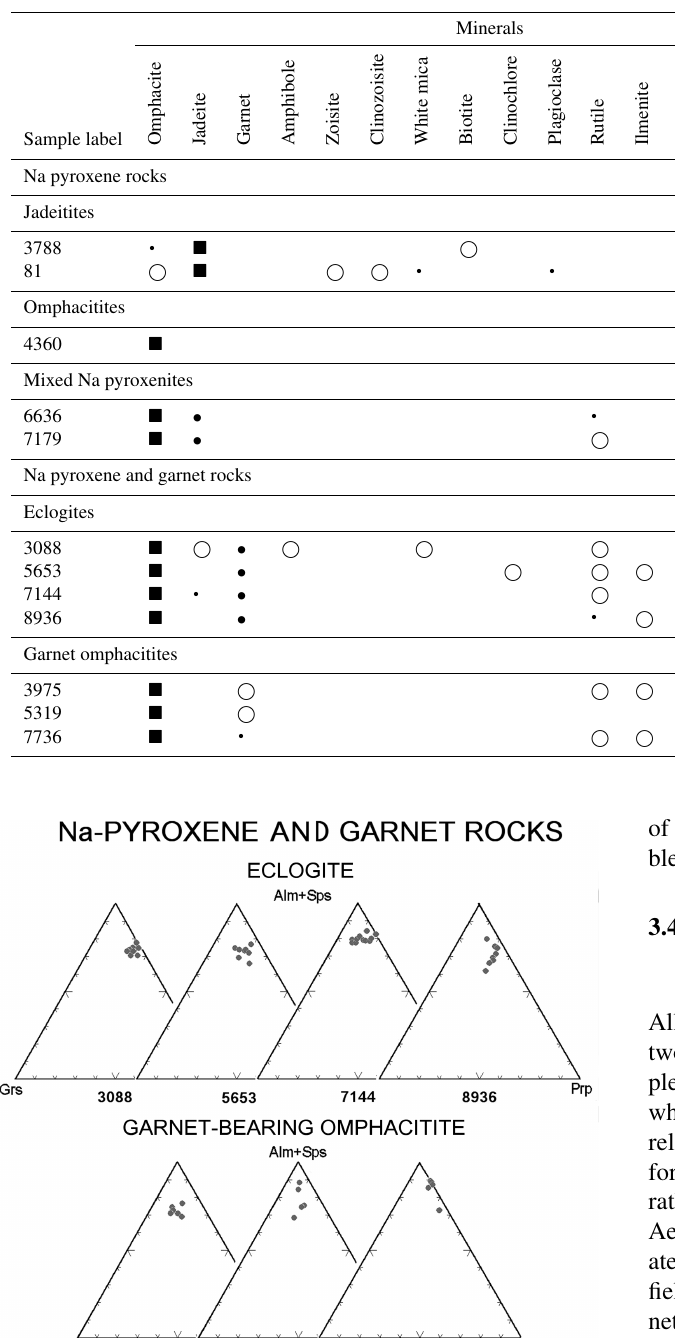
Table 3. Mineralogical composition (vol%) of 12 polished stone implements in HP meta-ophiolites (five Na pyroxene rocks and seven Na pyroxene and garnet rocks) from the archaeological site of Chiomonte, La Maddalena, obtained by combining X-ray powder diffraction, (cid:113) polarising microscopy and SEM-EDS on thin sections. Legend: (cid:13) < 5%, 5%–20%, • 20%–60%, (cid:4) > 60%. Minerals